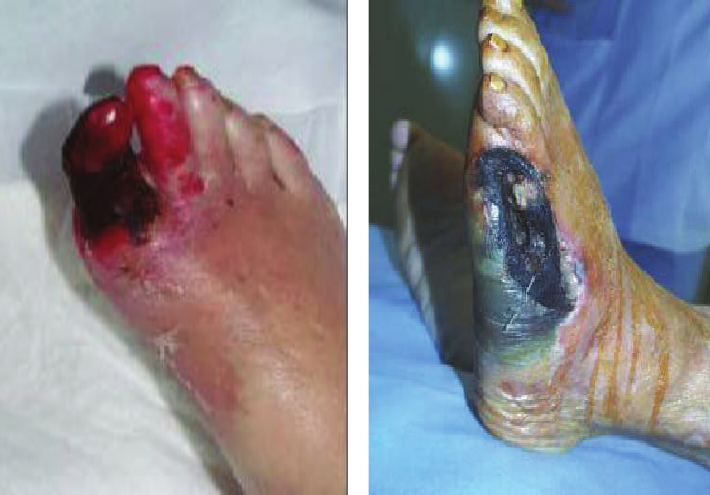
Figure 4: Infected diabetic